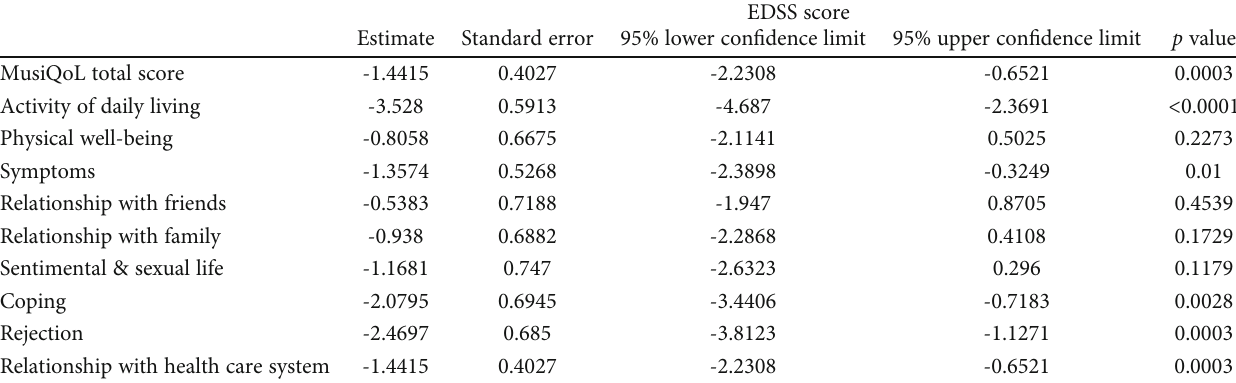
Table 4: Relationship between change in EDSS score and change in overall and domain-speci fi c MusiQoL scores over